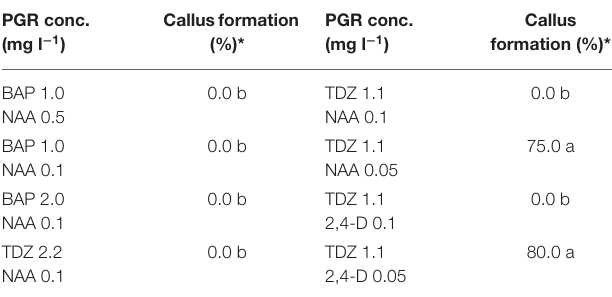
TABLE 2 | Effect of PGRs in MII medium on protoplast development of